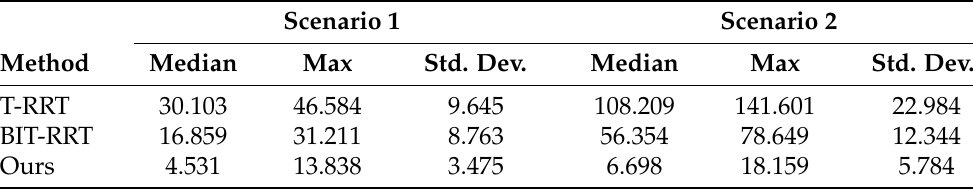
Figure 14. Experimental scene of disassembling for terminal with Wire. ( a ) Overall layout of the experiment. ( b ) Partial enlarged view. Table 3. Comparison of the planning time (s) of planners.